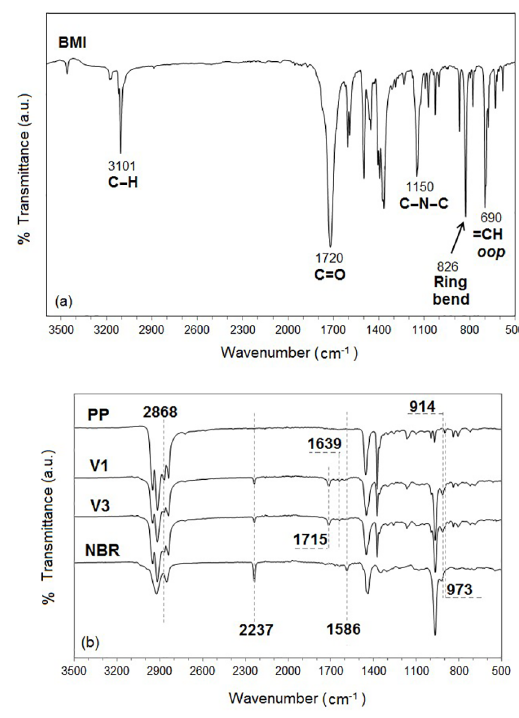
Figure 4. FTIR spectra of neat BMI by KBr method (a) and Typical ATR-FTIR spectra of neat PP, neat NBR and PP/NBR (50/50) TPV mixers by different rotor speed profile (b). V1= 60/60/60 rpm and V3=60/40/60 rpm.